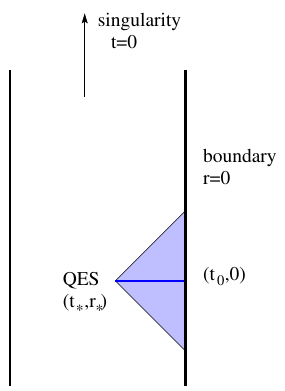
Figure 3 . Cartoon of the 2-dim geometry, the holographic boundary at r = 0 and the QES at ( t ) . The solid blue line is the spatial interval between the boundary observer and the QES. The ∗ , r ∗ singularity is at t = 0 far up (not shown). The extremization drives the QES location to t (far from the singularity) and r (which is the left vertical ∗ → ∞